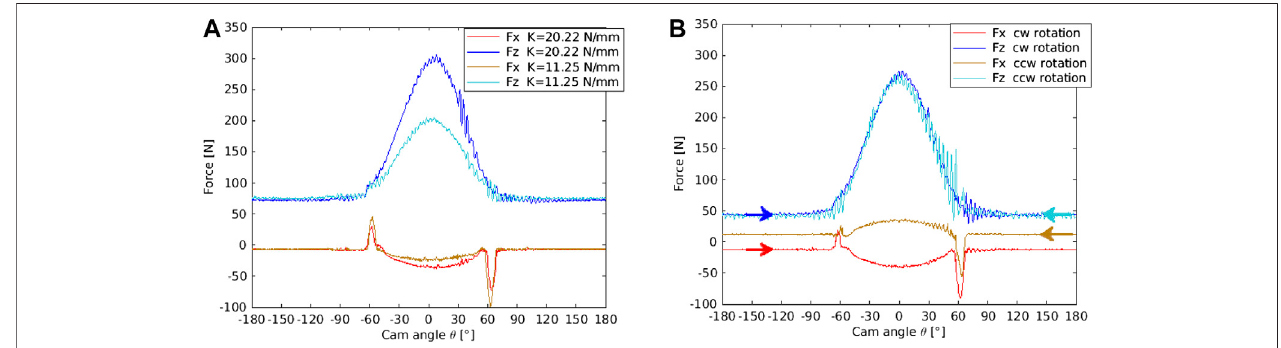
FIGURE 13 | Normal (F (A) Results obtained with two different spring stiffness K (clockwise z ) and friction ( F x ) forces measured during a cycle for the spline cam. rotation at 60 rpm with 75 N preload). (B) Results obtained with two different directions of rotation, clockwise (cw) and counterclockwise (ccw) (spring stiffness 20.22 N/mm, 60 rpm, 45 N preload).